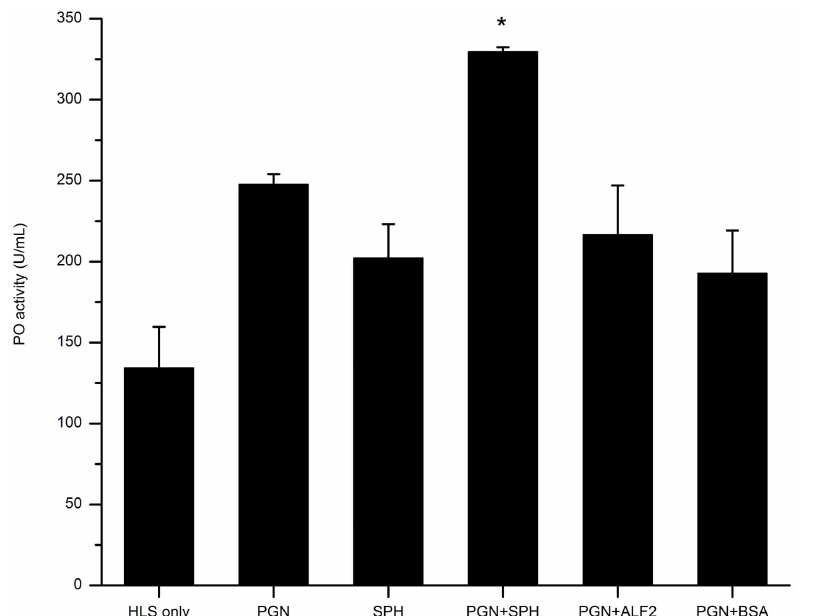
Figure 5. Phenoloxidase activity enhanced by Sp-SPH protein in the HLS of mud crab. PGN, Sp-SPH, PGN/Sp-SPH, PGN/Sp-ALF2, or PGN/ BSA was added to the mud crab HLS, respectively. The PO activity of HLS was then determined by using L-dopa as substrate and defined as U/mL. Significant difference in PO activity was marked as stars (paired t -test, P , 0.05). HLS: hemocyte lysate supernatant; PGN: peptidoglycan + HLS; SPH: Sp- SPH + HLS; PGN + SPH: peptidoglycan + Sp-SPH protein + HLS; PGN + ALF2: peptidoglycan + antilipopolysaccharide factor2 + HLS; PGN + BSA:peptidogly- can + bovine serum albumin + HLS. This experiment was repeated three times and the data represented means of triplicates. Bars indicated mean 6 S.E. ( n =3).